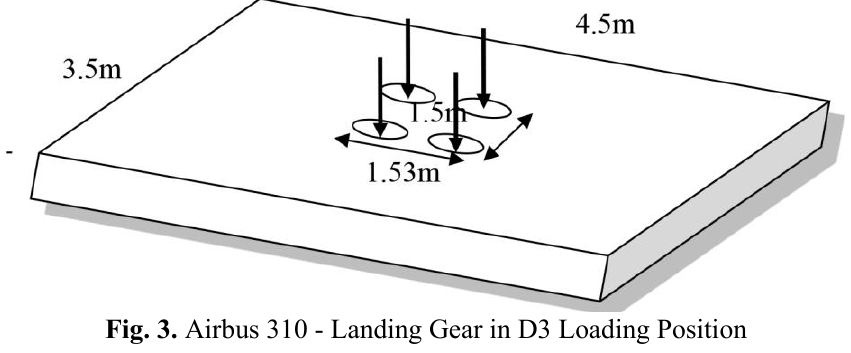
Fig. 3. Airbus 310 - Landing Gear in D3 Loading Position